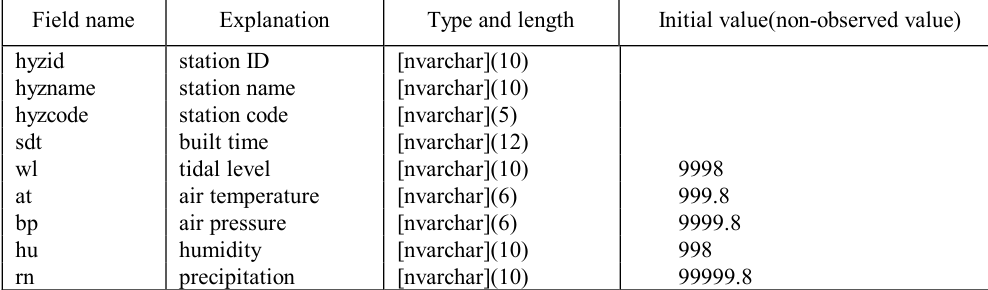
Table 2. The structure of real­time observation data table